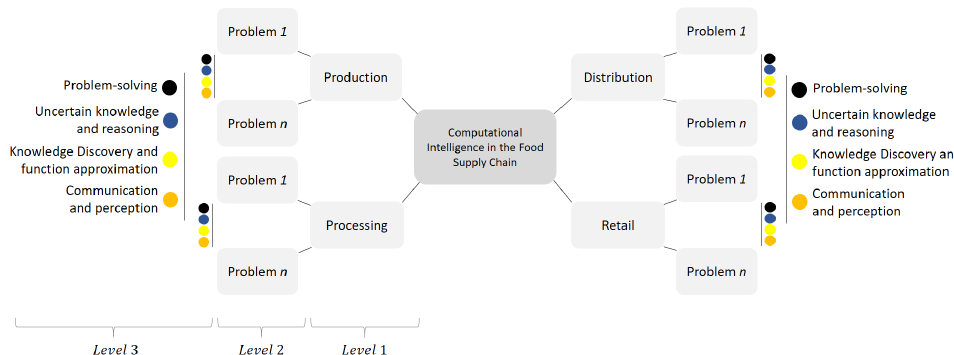
Figure 5. A taxonomy of computational intelligence in an FSC.